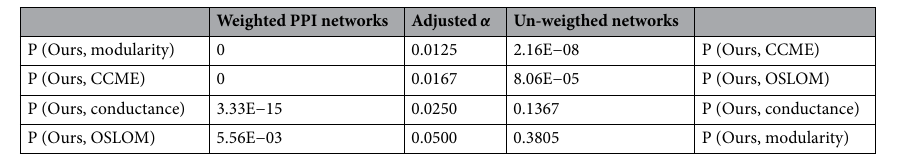
Table 2. The p -value P( a , b ) for the rank difference between two methods under the Holm’s step-down test on weighted PPI networks (the left column) and un-weighted networks (the right column), where a denotes our method and b represents a competing internal validation metric. In the middle column, the adjusted significance level at α = 0.05 for each position after sorting the p -values in a non-decreasing order is listed.